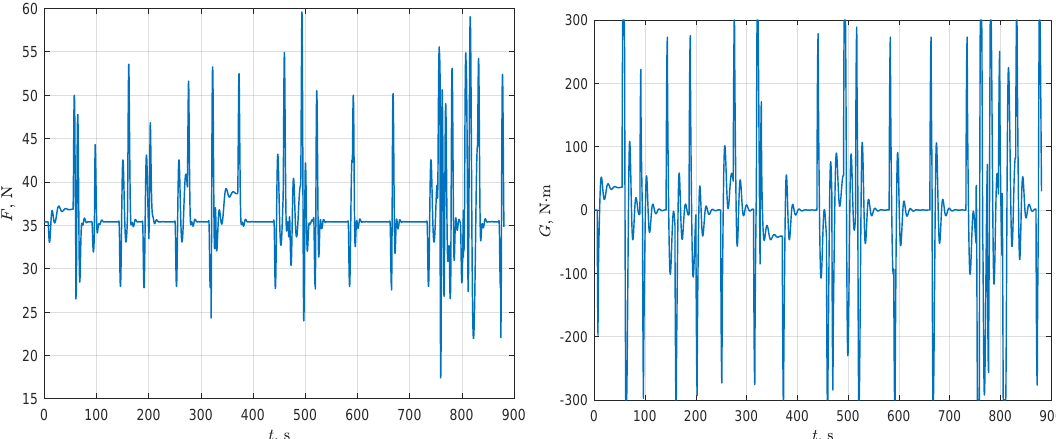
Figure 12. Control activity for Scenario 1: force (left-hand part) and torque (right-hand